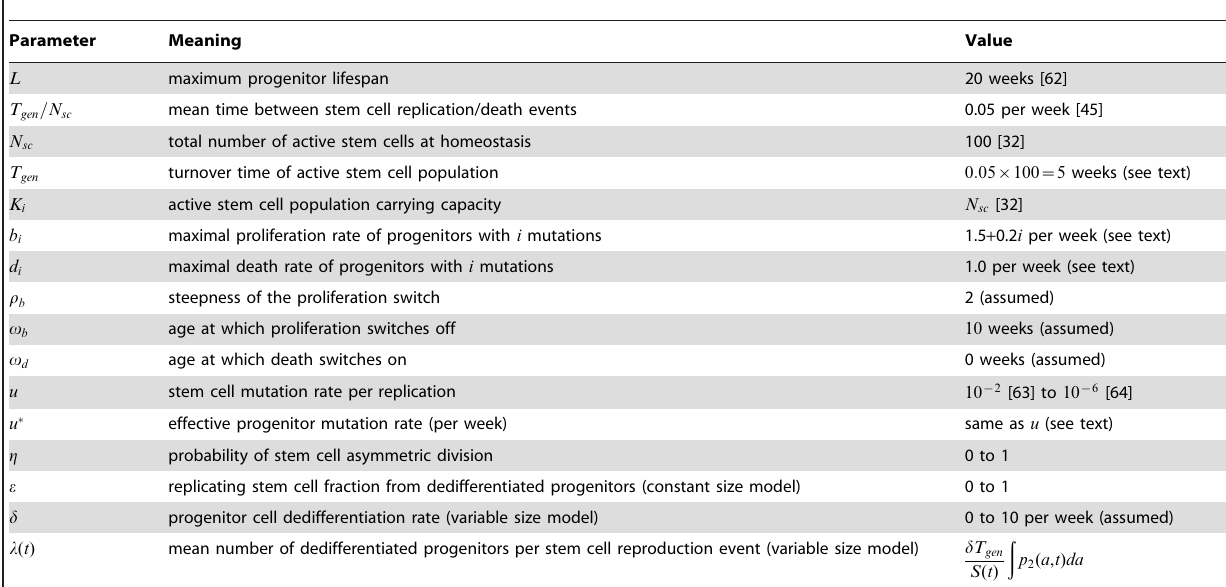
Table 1. Parameter values used in numerical